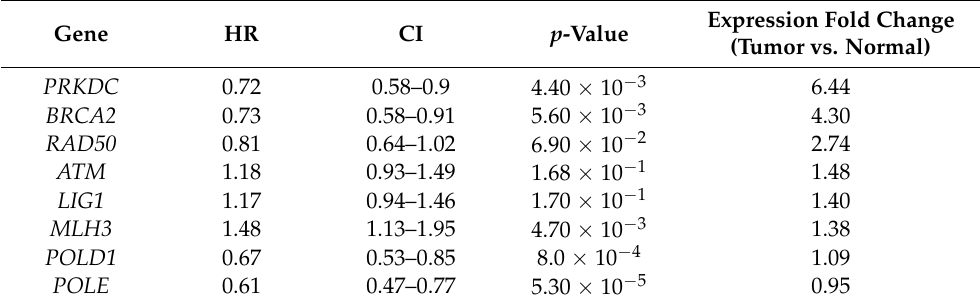
Table 2. Results of the survival analysis for the expression of the top genes associated with high mutation burden in colorectal cancer patients. RFS = relapse-free survival, CI = 95% confidence interval. Gene HR CI p -Value